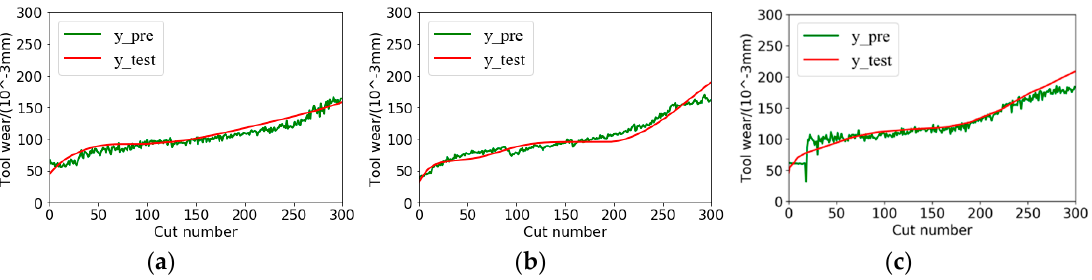
Figure 10. Regression performances of TDConvLSTM for three different testing cases: ( a ) C1; ( b ) C4; ( c ) C6.